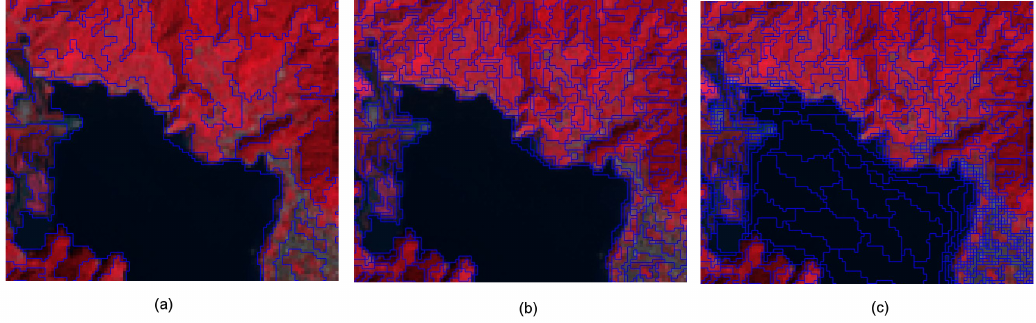
Figure 2. The result of multi-resolution segmentation of Landsat images at: ( a ) Level 1; ( b ) Level 2; and ( c ) Level